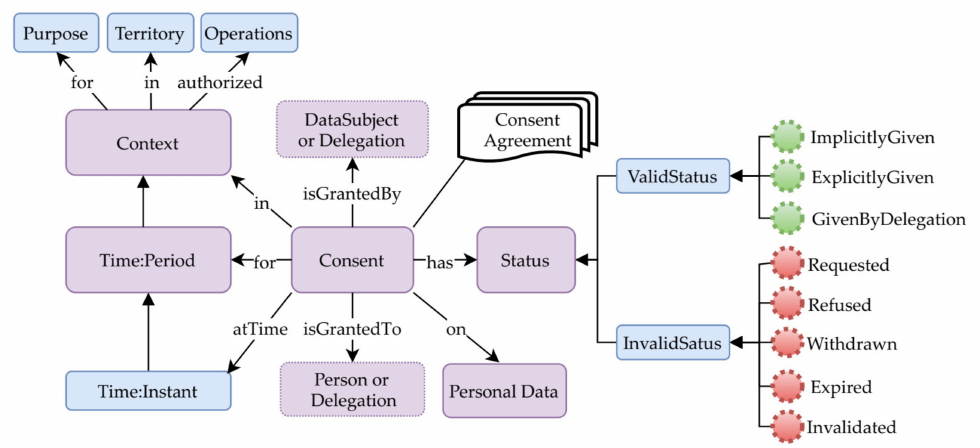
Figure 1. Consent concepts representation using ontology.